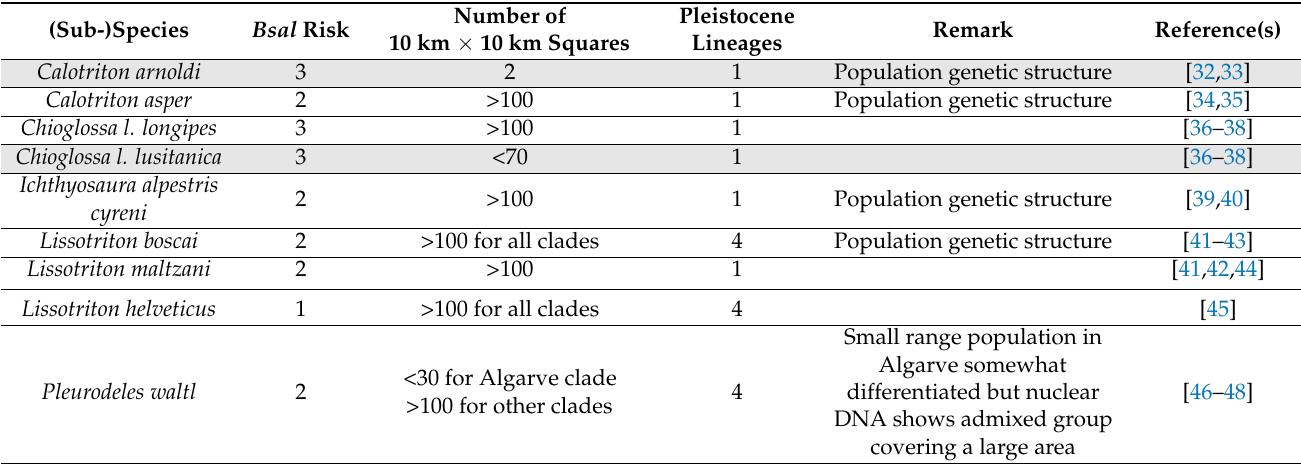
Table 1. Iberian urodeles’ susceptibility to Bsal infection (1 = low, 2 = intermediate, 3 = high), an estimate of the number of 10 × 10 squares occupied by small range lineages (<100 squares) and their known genetic Pleistocene lineages as a proxy for conservation units. We highlight the existence of population genetic structure and other relevant information regarding the spatial genetic structure obtained from the literature (references) for each species/lineage. Shaded rows represent conservation units considered at highest